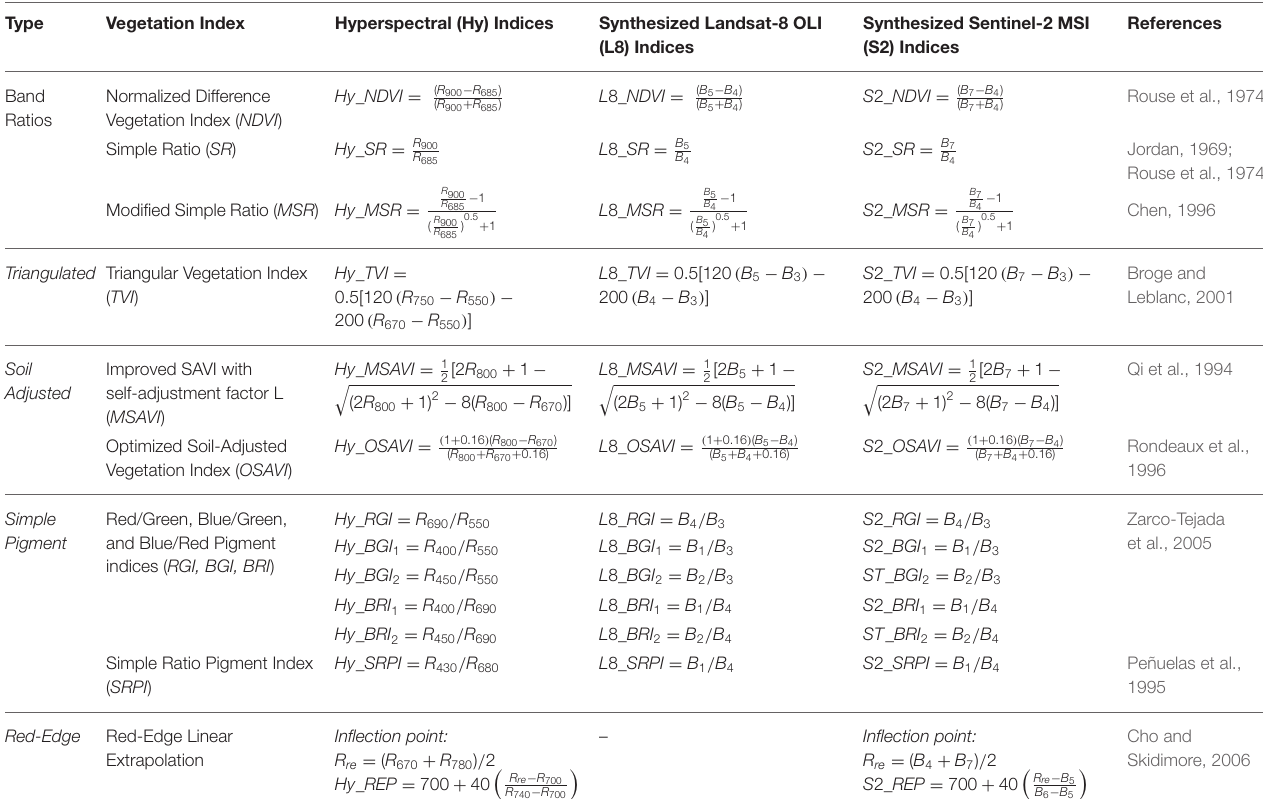
TABLE 3 | Formulas of vegetation indices computed for hyperspectral (Hy) data and synthesized Landsat-8 OLI (L8) and Sentinel-2 MSI (S2) data [derived from Zarco-Tejada et al. (2005) and le Maire et al.